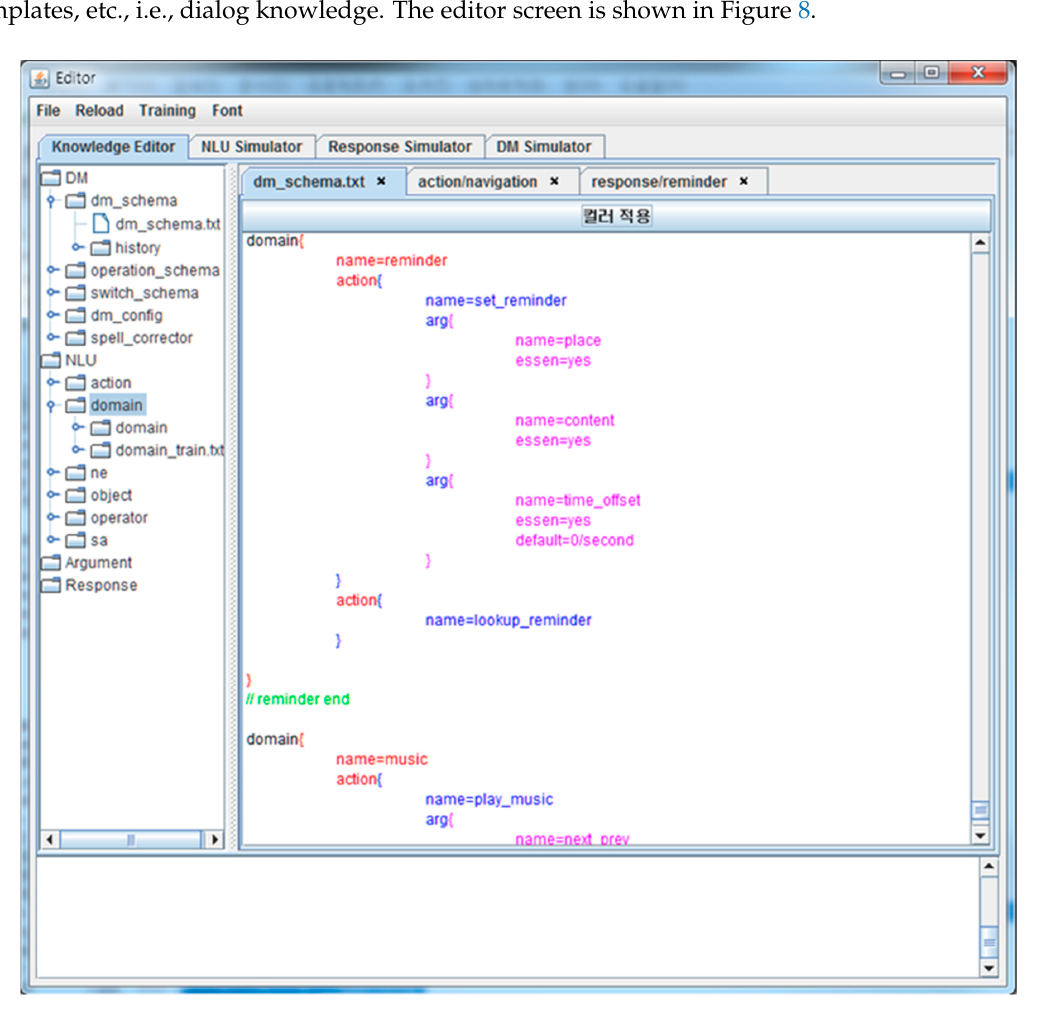
Figure 8. Screen shot of dialog knowledge editor. Table 1. Number of dialogs for experiments.